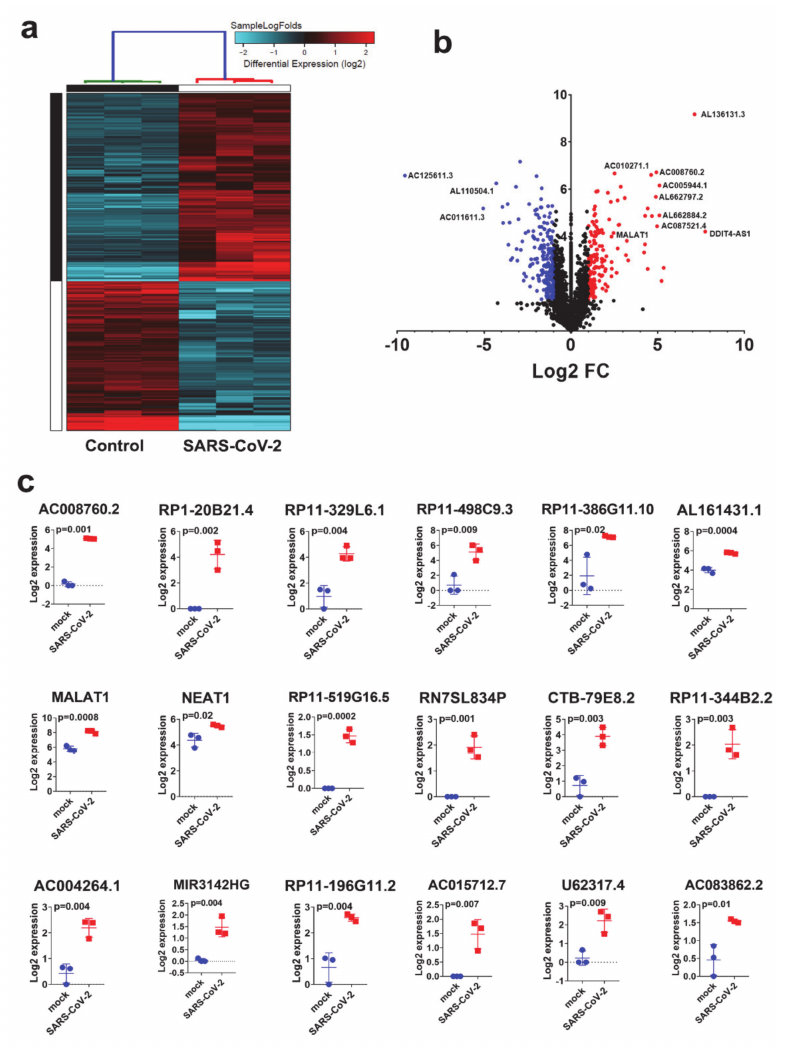
Figure 4. Clustering of SARS-CoV-2 and control NBHE cells based on lncRNA expression. ( a ) Hierarchical clustering of control and SARS-CoV-2 infected NHBE cells based on di ff erentially expressed lncRNAs. Each column represents one replica, while each row represents one lncRNA. Expression is depicted at the indicated color scale. ( b ) Volcano plot representation of di ff erential expression analysis of lncRNAs in NHBE SARS-CoV-2 vs. mock infected cells. Red and blue colors indicate the genes with significantly increased or decreased expression, respectively. ( c ) Expression of selected lncRNAs in mock and SARS-COV-2 infected NHBE